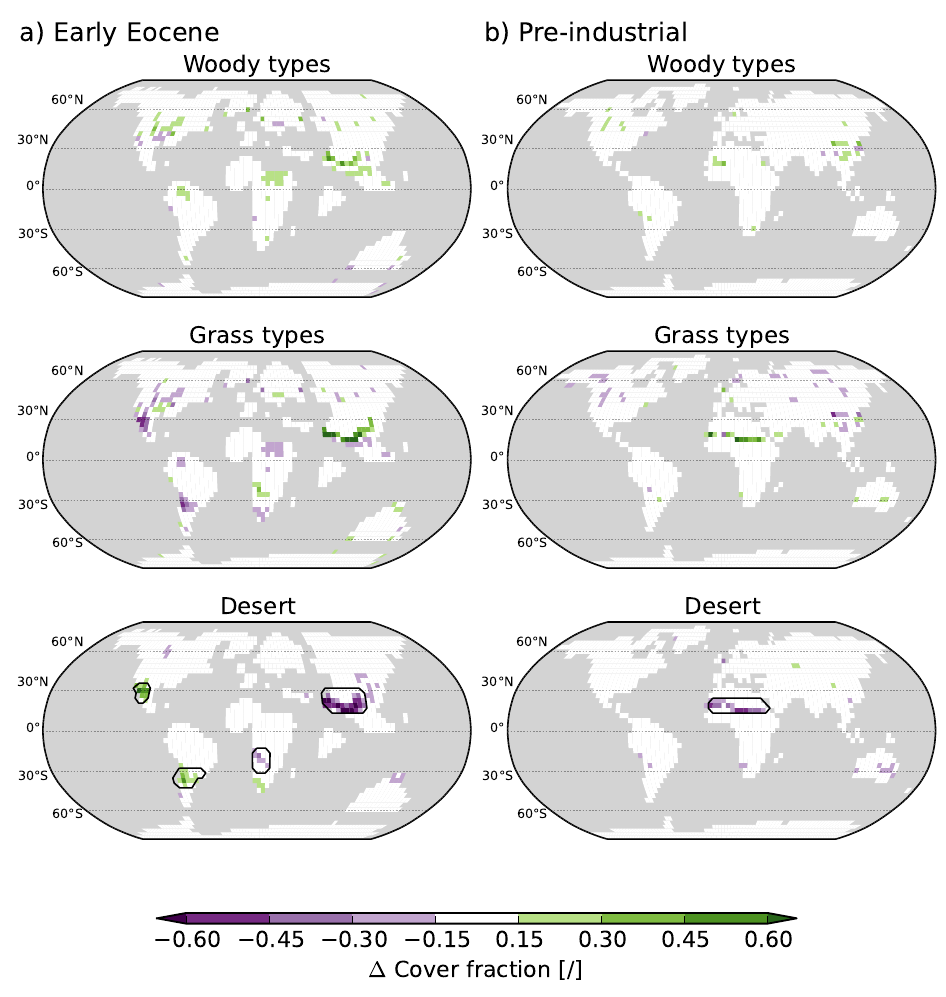
Figure 3. Differences in vegetation cover between the simulations that start from a forest world and the simulations that start from a desert world. Differences for the early Eocene climate (FE d –DE d ) (a) and for the pre-industrial climate (FP d –DP d ) (b) are shown. Mapped differences refer to the average over 30 years and are significant on a 95% level. Woody types include all trees and shrubs. Grass types refer to C 4 grass and to C 3 grass. Black contour lines mark regions which are analysed in more detail in Figs. 4 and